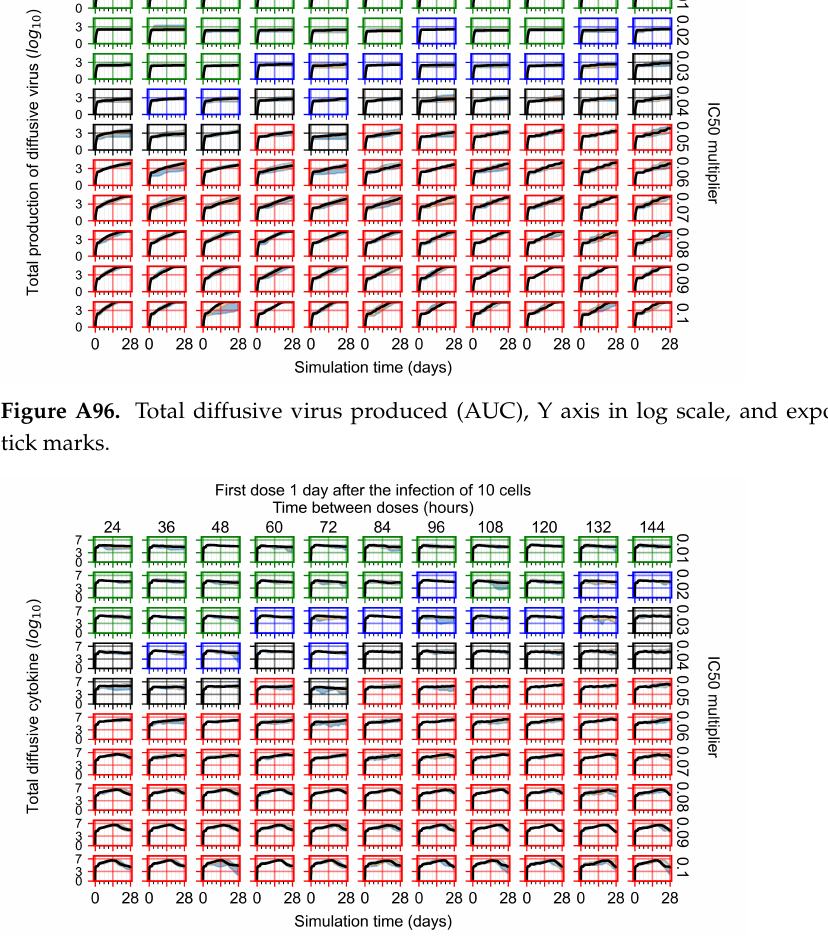
Figure A97. Diffusive cytokine amount for eight replicas of the treatment simulation, Y axis in log scale, and exponent values as tick